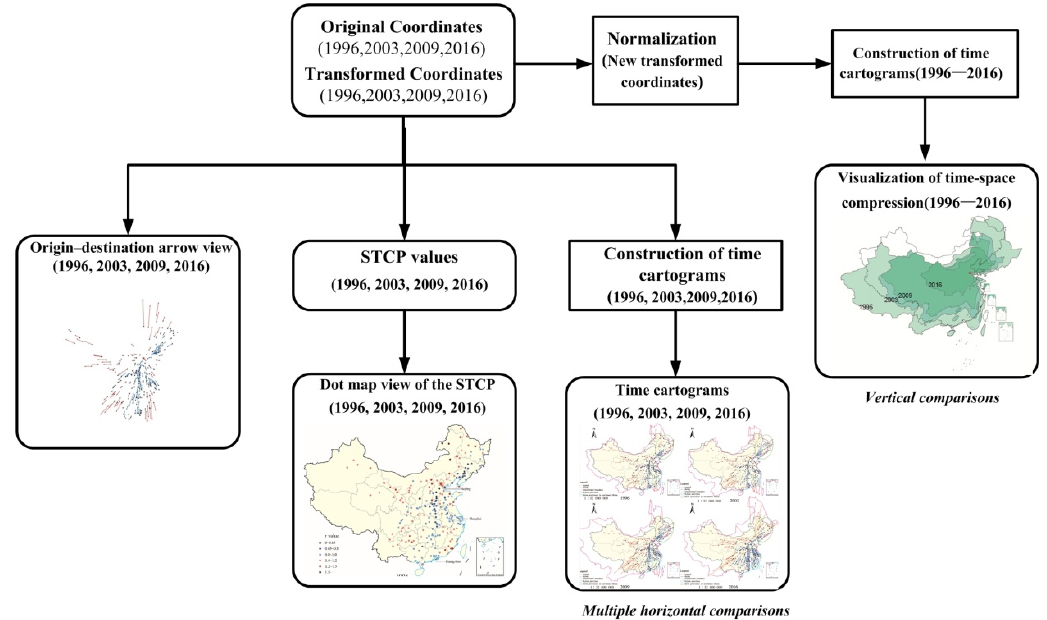
Figure 3. The methodology of this